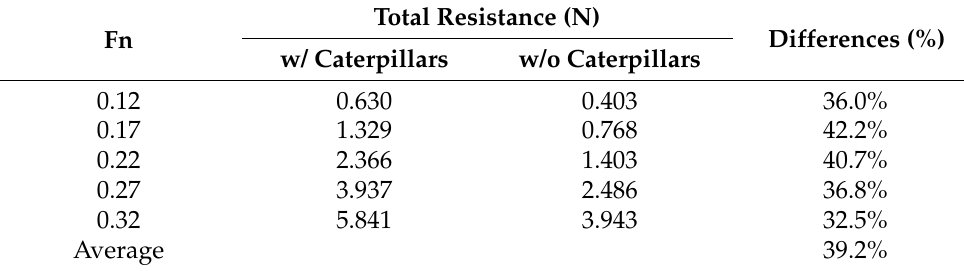
Table 3. Numerical simulation results of vessels w/and w/o caterpillars.